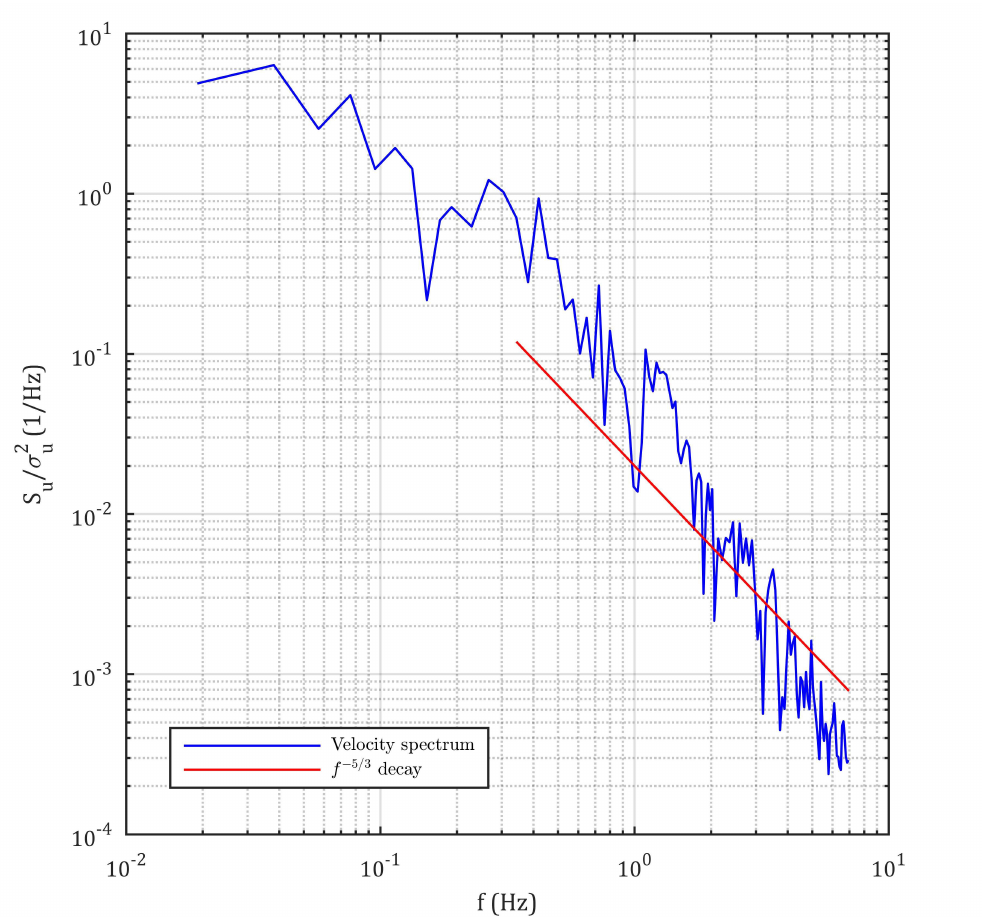
Figure 12. Power spectral density of the longitudinal component of